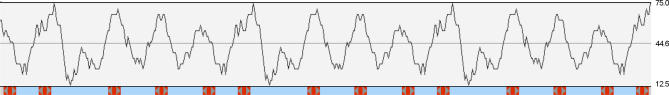
NIME Array Percentage G + C Content Profile for an Array Located at 1283600–1284640 bp in the FAM18 GenomeThe % G + C window size is 24 bases. Maximum, minimum, and median are also shown. Red blocks represent dRS3 with inverted repeats indicated by grey triangles. Blue blocks represent RS elements.